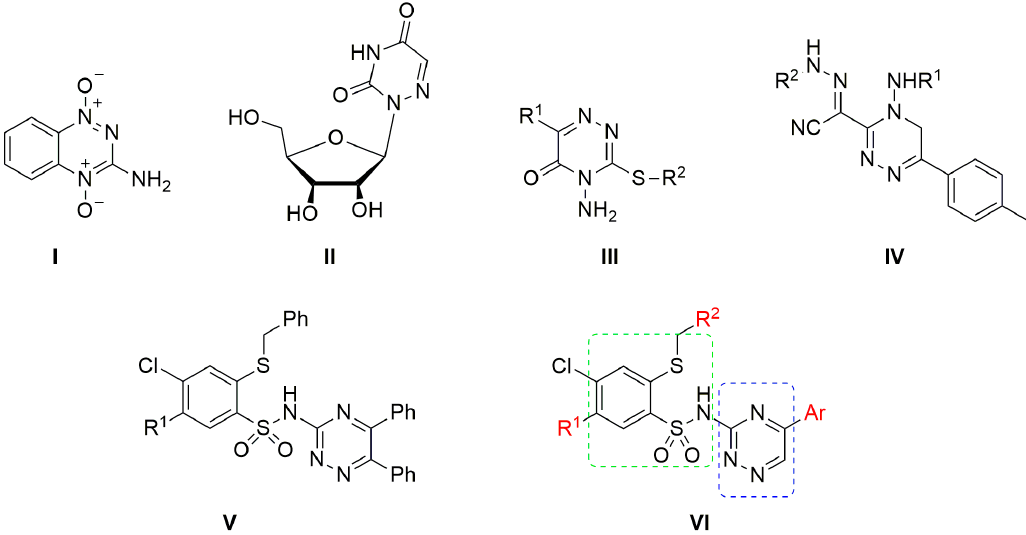
Figure 1. Structures of known anticancer 1,2,4-triazines ( I – V ) and novel 2-(arylmethylthio)-4-chloro- N -(5-aryl-1,2,4-triazin-3-yl)benzenesulfonamide derivatives ( VI ).